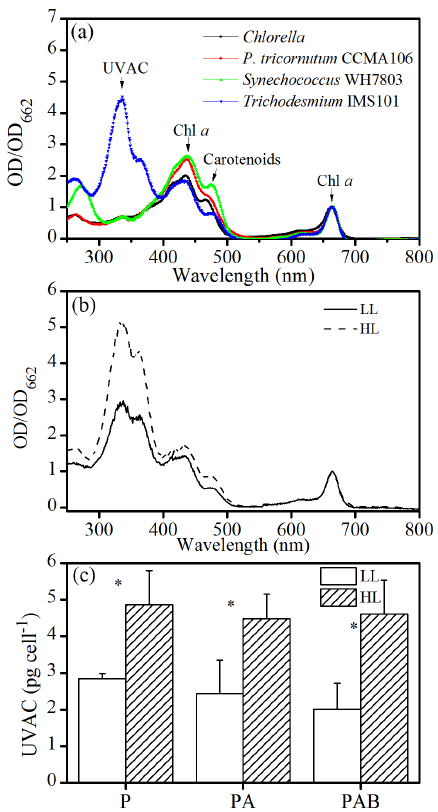
Figure 3. (a) Absorption spectrum of Trichodesmium IMS101 com- pared to other phytoplankton. Pigments were extract by 100% methanol. OD value normalized to OD 662 (Chl a) . (b) Absorption spectrum of the Trichodesmium IMS101 grown under LL and HL conditions, with OD value normalized to OD 662 (Chl a) . (c) Cellu- lar contents of UVACs of Trichodesmium IMS101 grown under LL and HL conditions after exposure to PAR (P), PAR + UVA (PA), and PAR + UVA + UVB (PAB) under a solar simulator for 10h. Asterisks above the histogram bars indicate significant differences between LL- and HL-grown cells. Values are the mean ± SD for triplicate incubations.